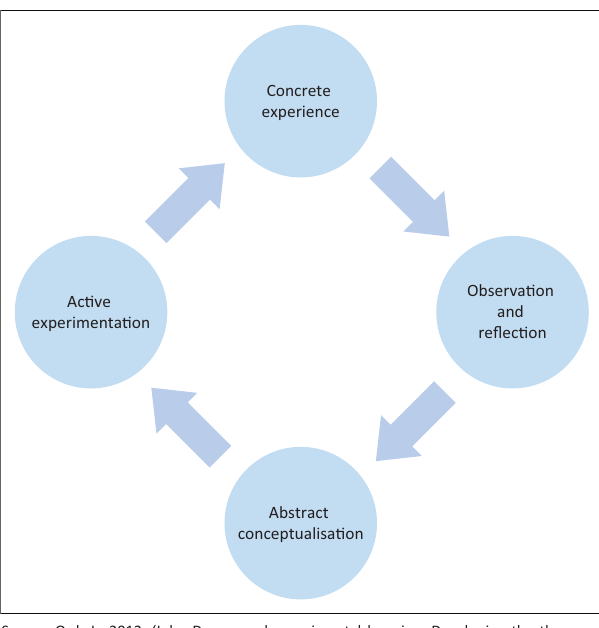
FIGURE 1: An explanation of Lewin’s experiential learning